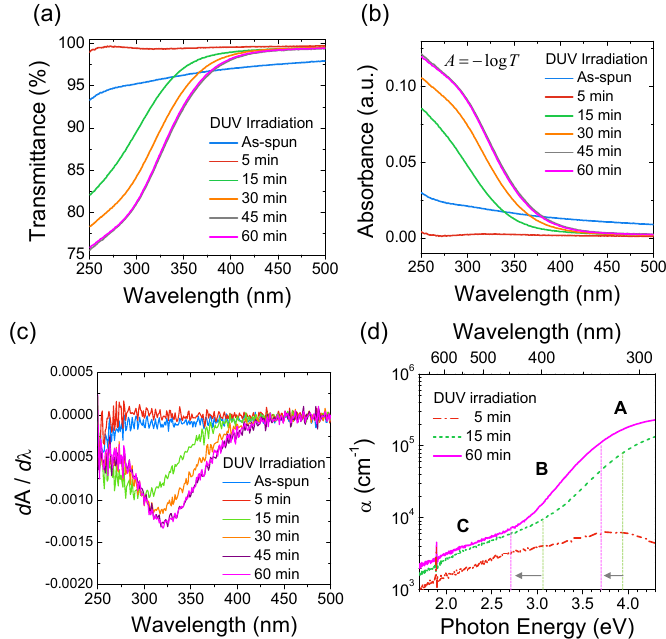
Figure 3. ( a ) Optical transmittance, and ( b ) absorbance data for as ‐ spun and photo ‐ activated IGZO films (DUV irradiation of 5–60 min). Here, the absorbance data were obtained from the transmittance data using an equation, A = –log T ; ( c ) The first ‐ order derivatives of absorbance ( A ʹ ‐λ ); and ( d ) absorption coefficient ( α ) vs. photon energy ( E ) for photo ‐ activated IGZO films.